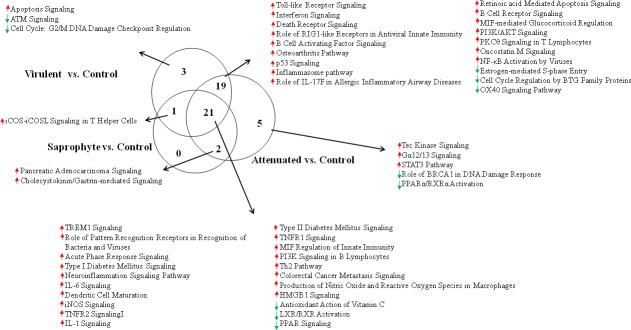
Venn diagram for pathways of modulated macrophages at 6 hours of infection with different strains of Leptospira spp.Total number of canonical pathways (n = 3/treatment; FDR<0.05, fold change ± 2) in the contrasts Infected (Saprophyte; Attenuated and Virulent) vs. Non-infected Control.